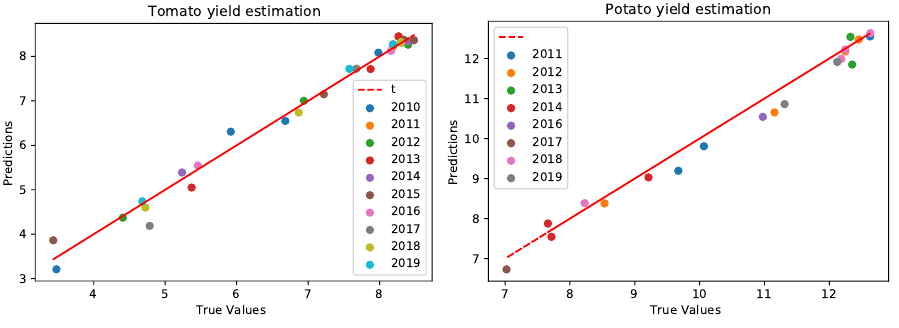
Figure 10. Predicted values vs. true